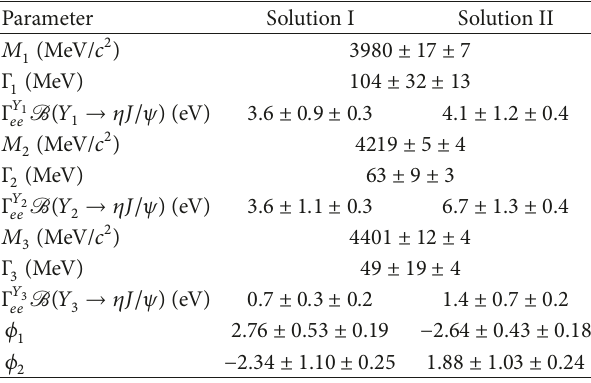
Table 1: The fitted parameters of the cross section of 𝑒 + 𝑒 − → 𝜂𝐽/𝜓 . The first uncertainties are statistical, and the second are